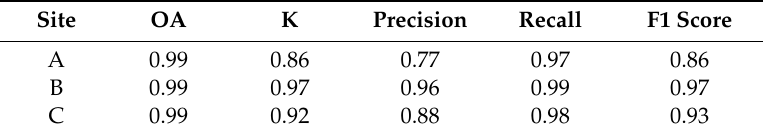
Table 4. Overview of the accuracy assessment for the three study areas including overall accuracy (OA), Cohen’s kappa coefficient (K), as well as precision, recall and the F1 score of the burned areas. Site OA K Precision Recall F1 Score A 0.99 0.86